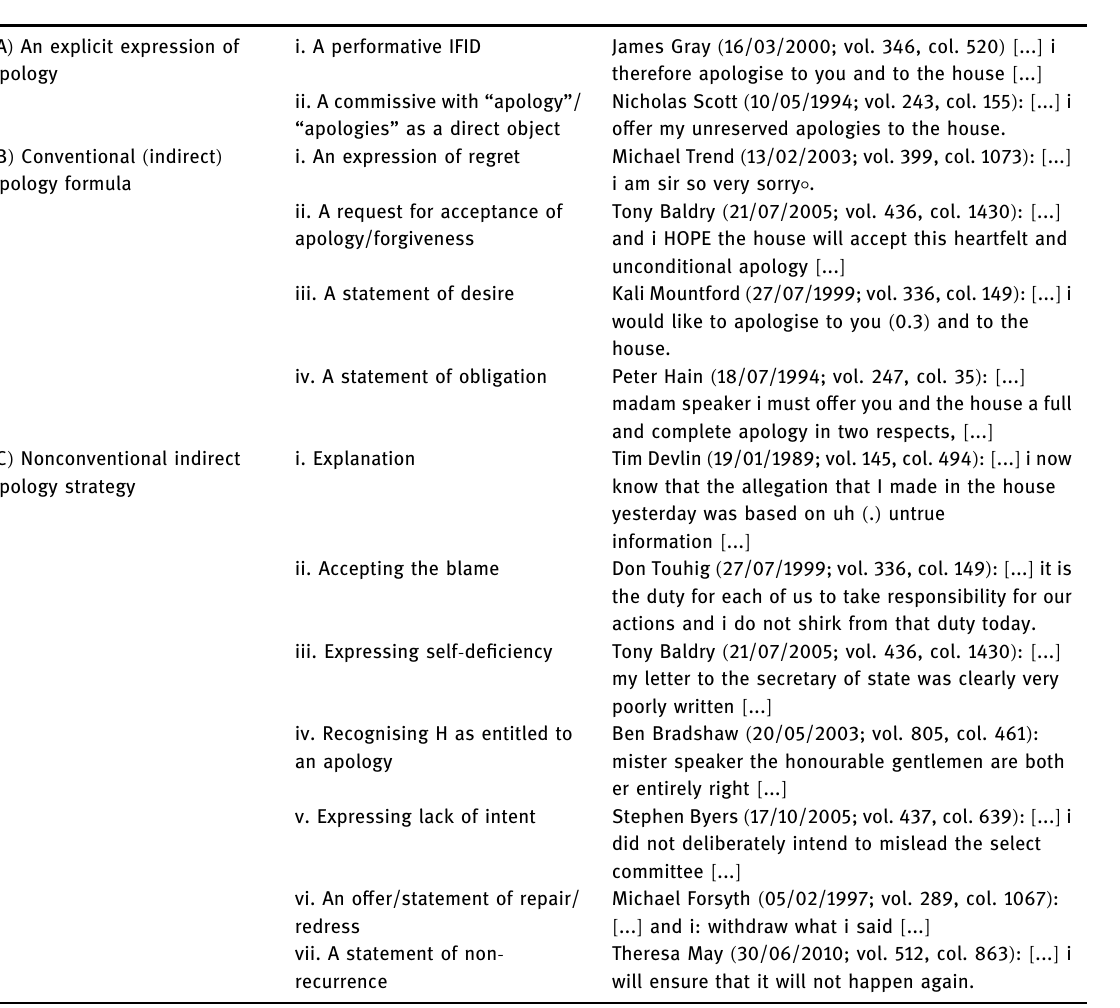
Table 2: Murphy ’ s ( 2014 ) apology